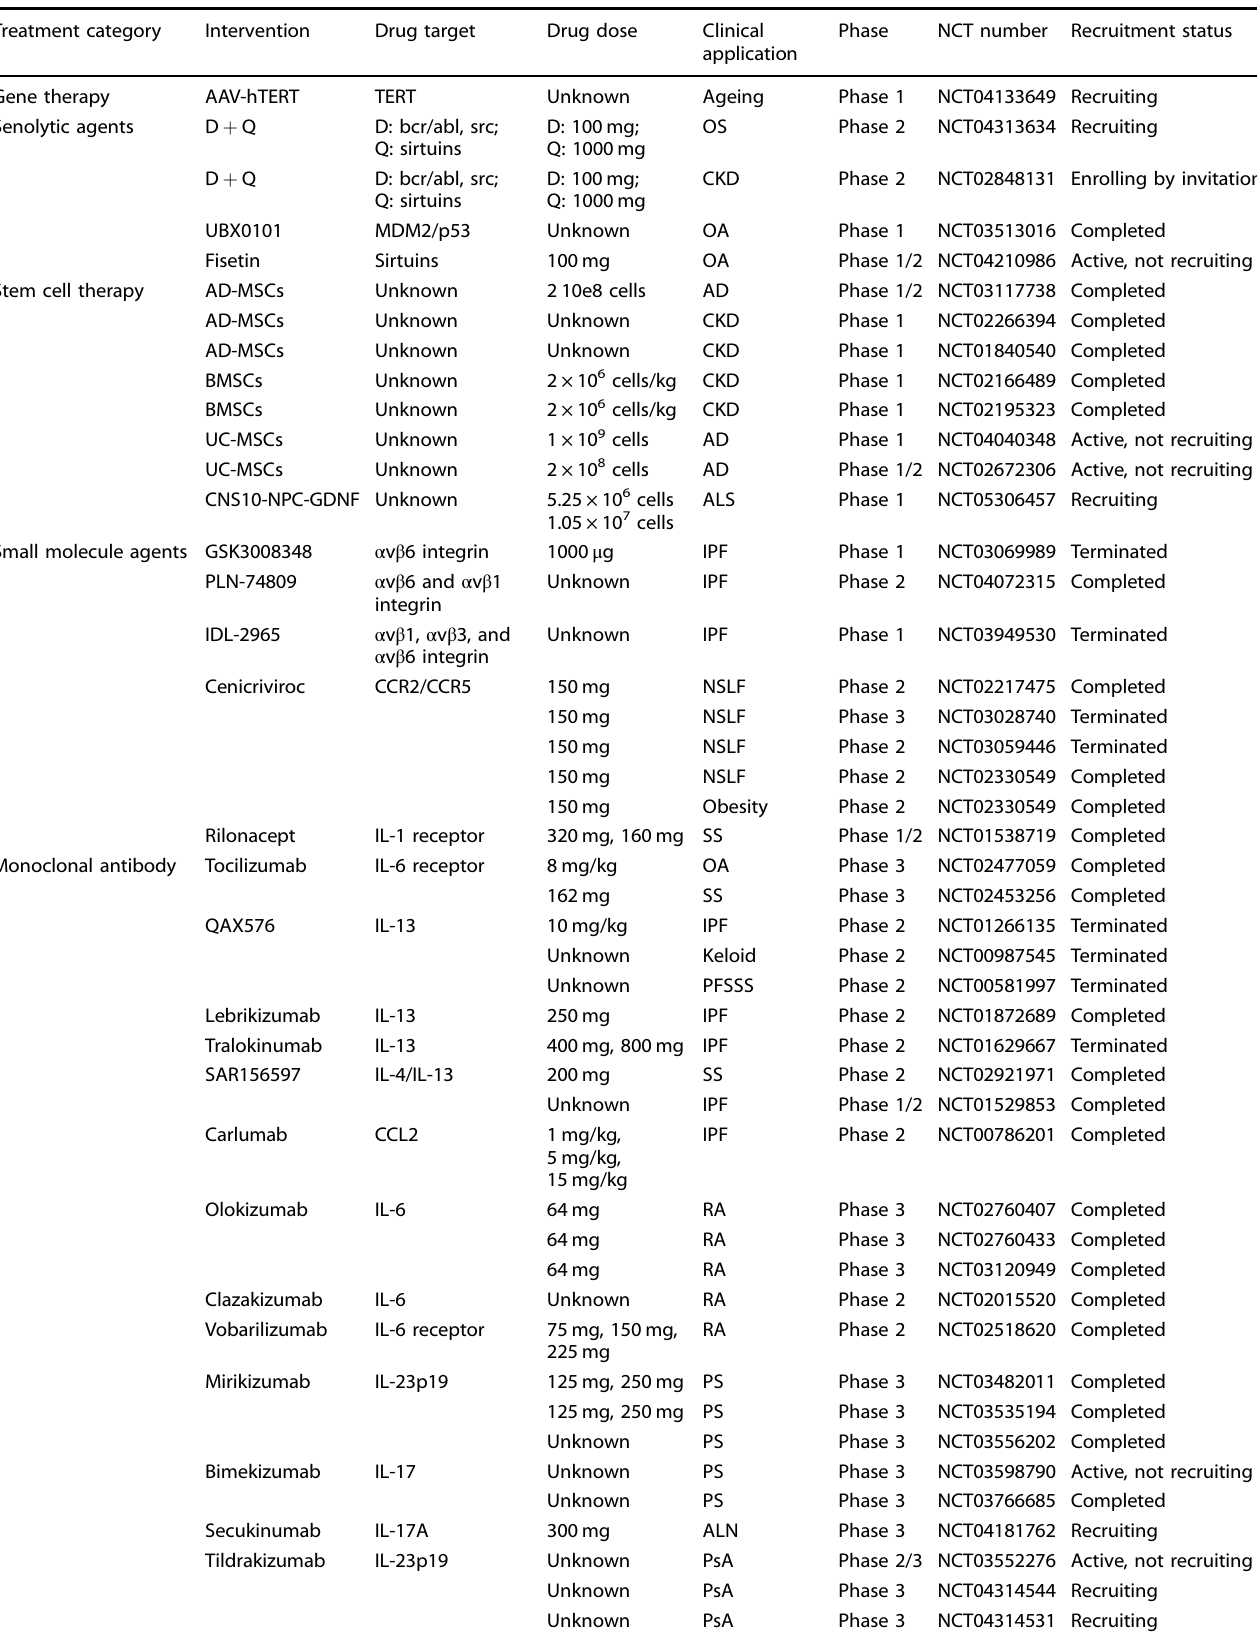
Table 3. Clinical trials of developed therapy in ageing and ageing-related diseases Treatment